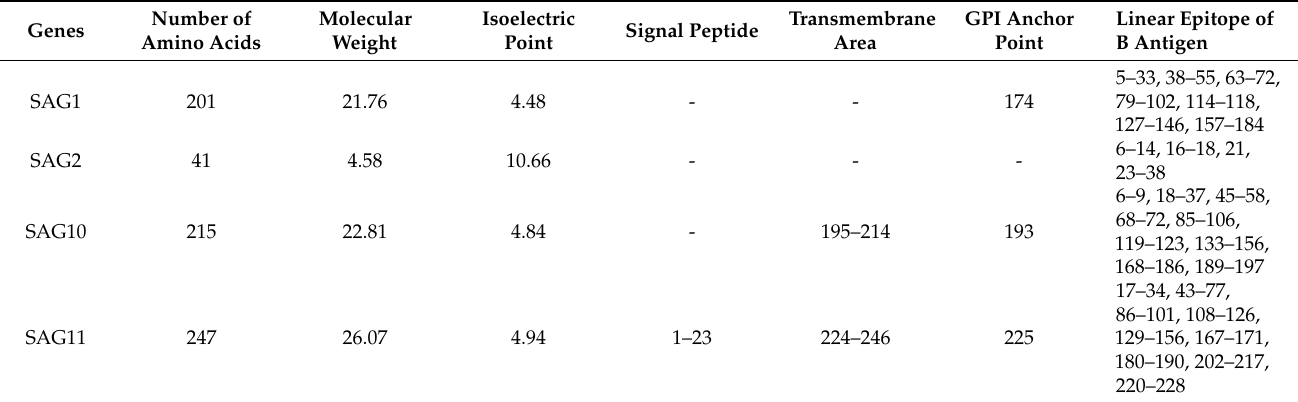
Table 1. Analysis of the basic molecular characteristics of